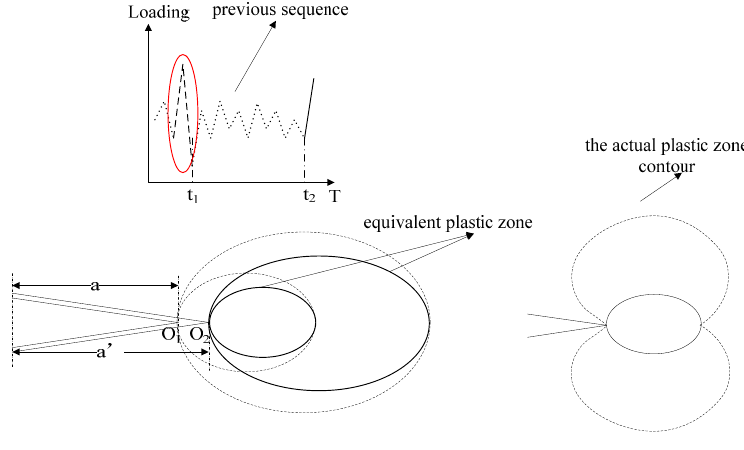
Figure 18. Schematic illustration of the equivalent plastic zone concept.